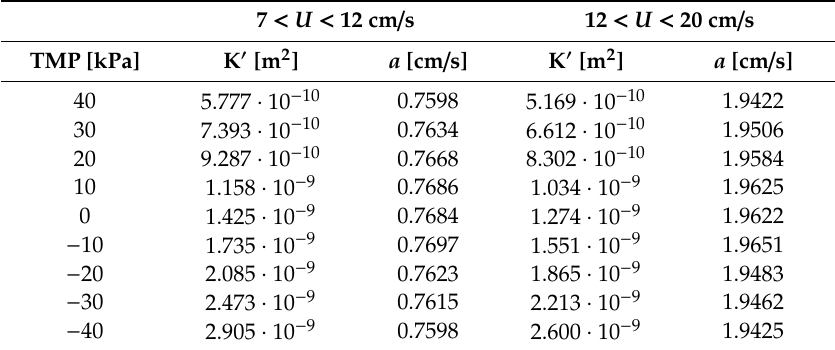
Table A3. Slopes and intercepts for superficial velocity ranging between 7 and 20 cm /